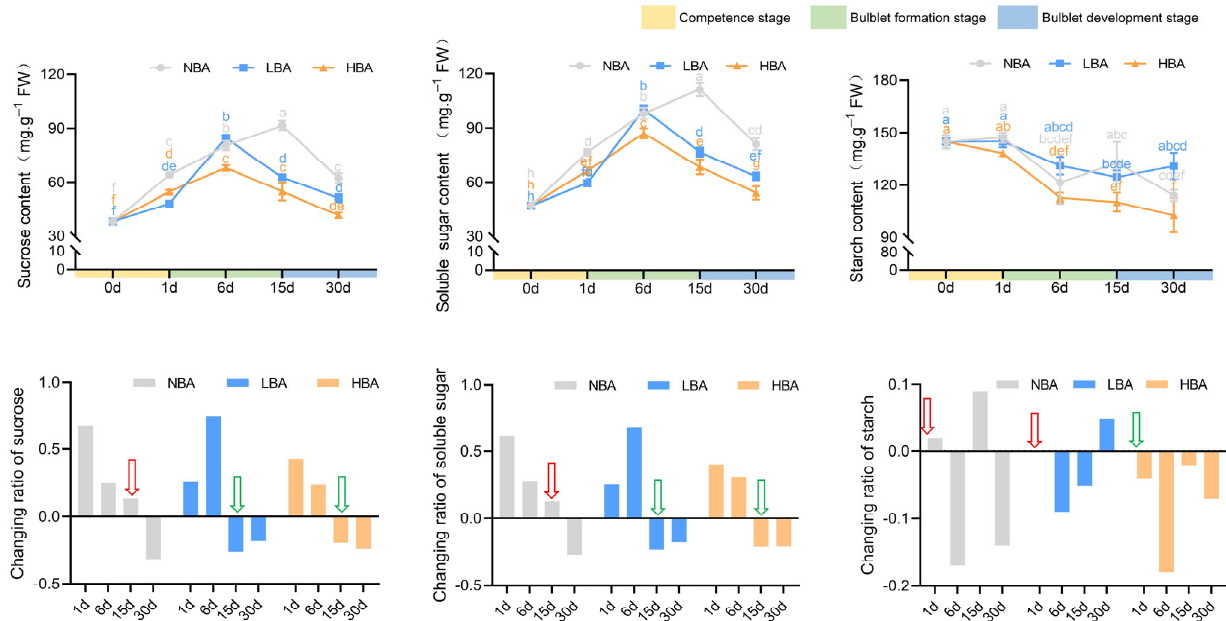
Figure 4. The changes in non ‐ structural carbohydrate contents during the bulblet regeneration process of Lycoris sprengeri in vitro. Data are represented as the means ± SEM ( n = 3 biological replicates). Different letters indicate significant differences at p < 0.05 according to Duncan’s multiple range test. The red arrow indicates a positive changing ratio of rate of non ‐ structural carbohydrate contents while the green one indicates a negative changing ratio.